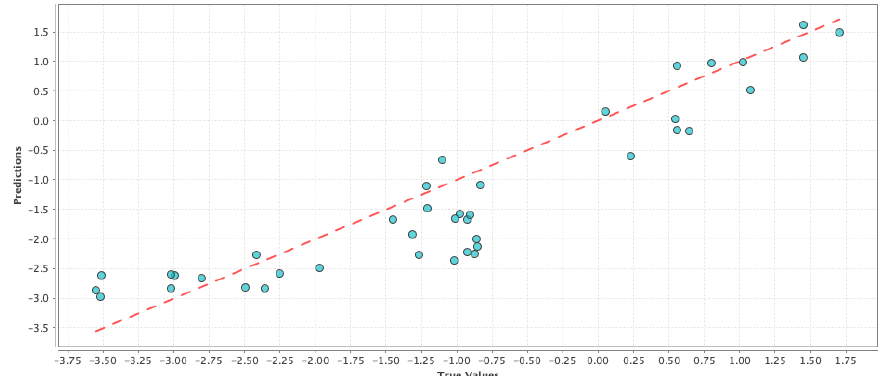
Figure 6. Result on Test Set For Deep Learning using Model 6 from Table 3. The x-axis represents the true or the actual PDSI values and the y-axis represents the predicted PDSI values. Each small blue circle in the figures is represented by the tuple ( PDSI actual , PDSI pred ). The red dashed line is the reference line to test the model performance. Table 7. Results on Test Set for Generalized Linear Model, Support Vector Machines and Deep